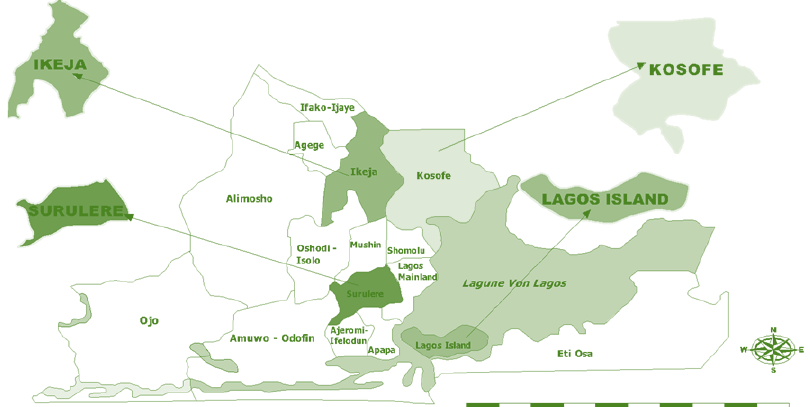
Figure 1. Map of Lagos Metropolis indicating selected Local Government Areas Source: Lagos State Secretariat, Ikeja